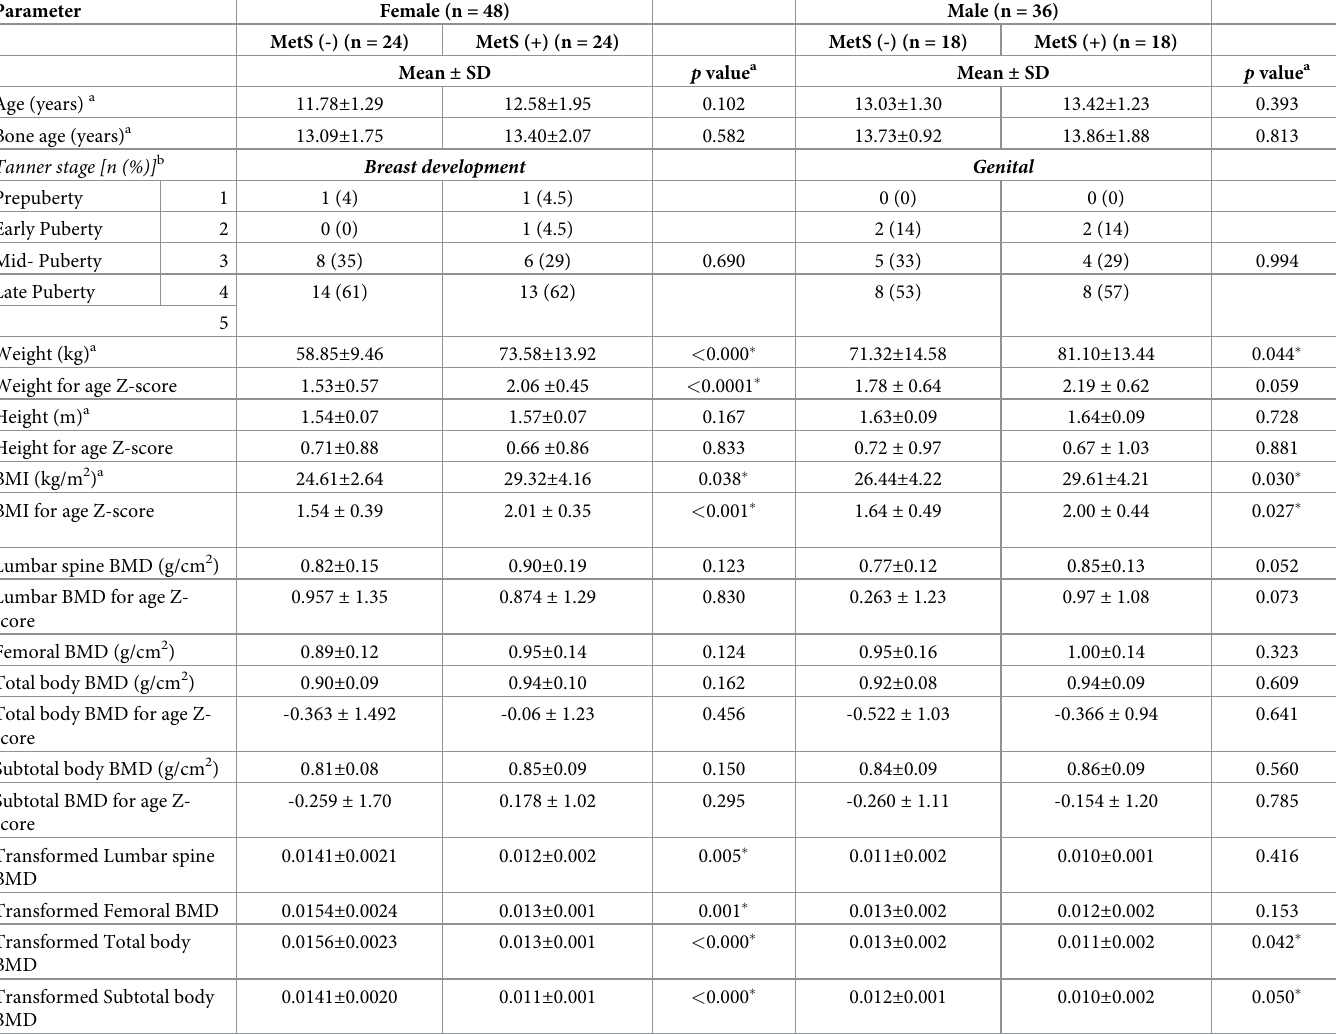
Table 1. Comparison of adolescents with and without metabolic syndrome according to sex, bone age, tanner stage, anthropometric measures, body mass index, BMD, and transformed BMD of both sexes.